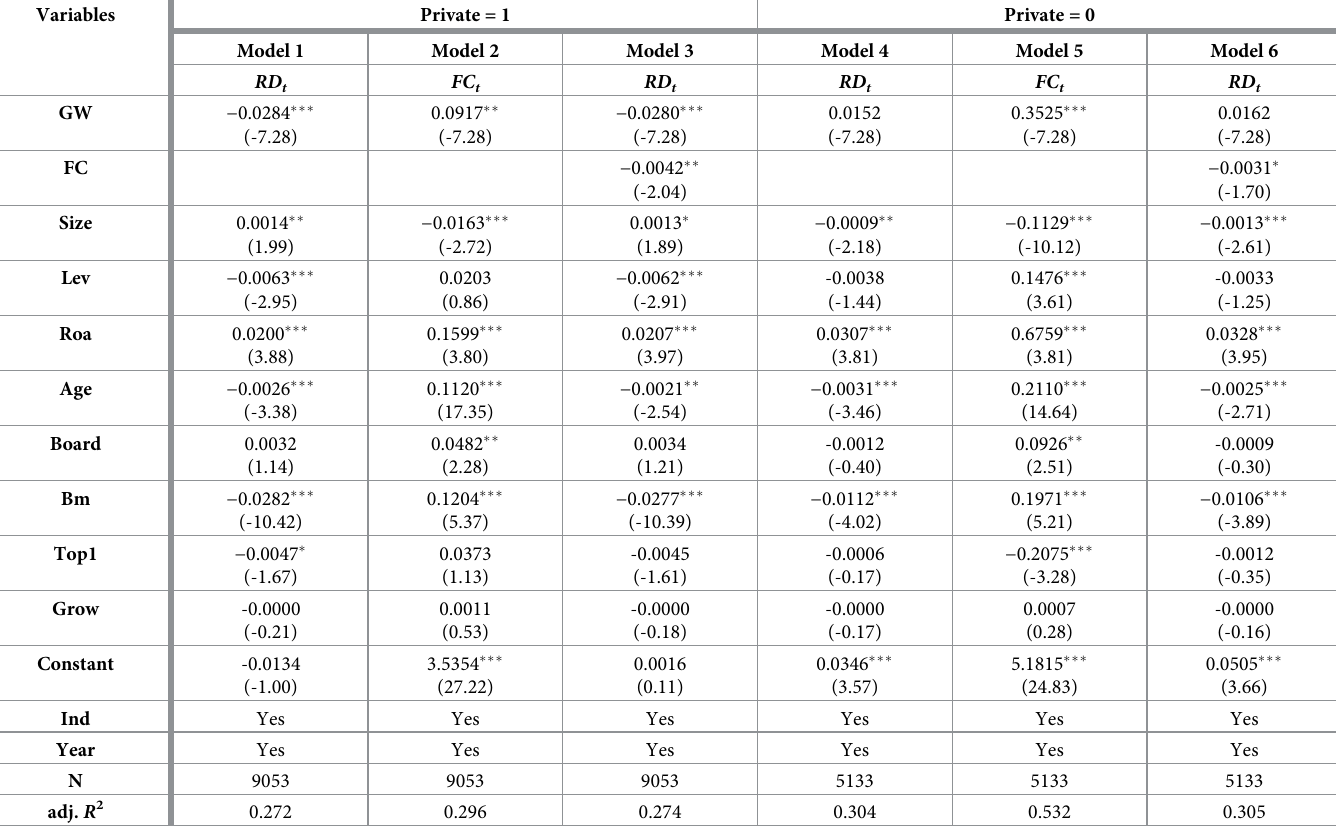
Table 5. Analysis of the mediating effects of financial constraints under different state ownerships.